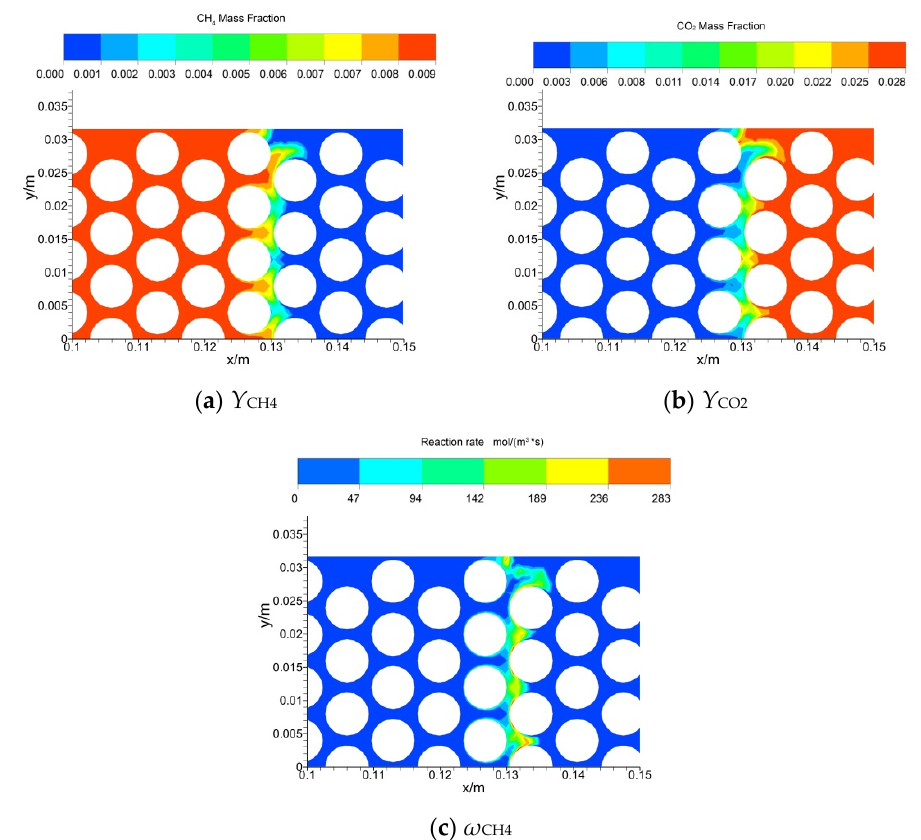
Figure 7. Mass fractions of methane and carbon dioxide and chemical reaction rate of methane with φ = 0.162, u 0 = 0.43 m/s at t = 656 s.